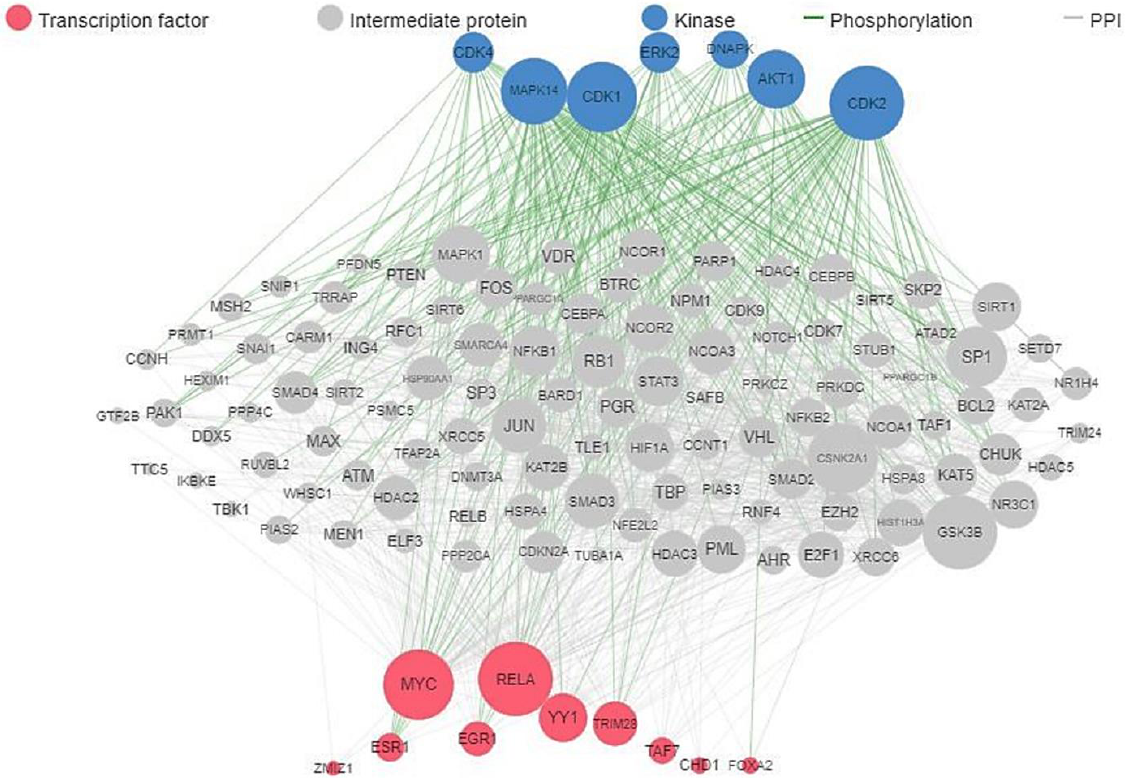
Figure 1. ALS published target gene network of kinases, protein-protein interactions, and transcrip- tion factors.